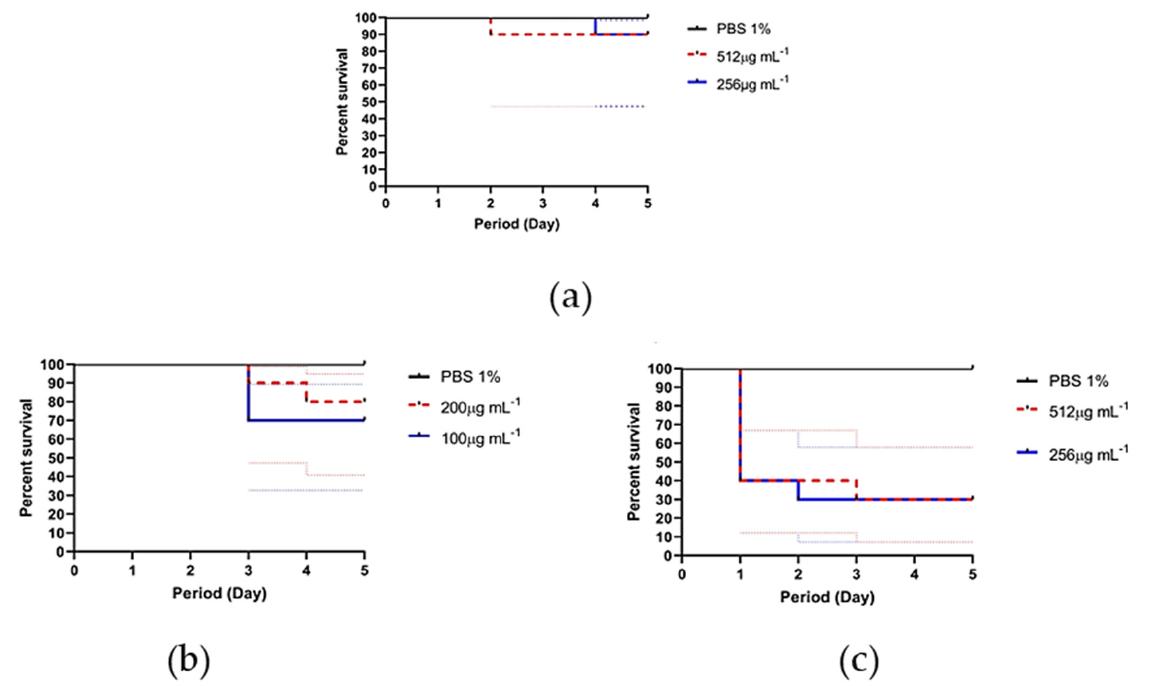
Figure 4. Survival curve of Tenebrio molitor larvae treated with crude extract or hexane fraction of Vernonanthura brasiliana (L.) H. Rob and leishmanicidal reference drug Glucantime ® . The larvae were treated and evaluated daily for a period of 5 days. ( a ) Larvae with hydroalcoholic crude extract (EB Vb ); ( b ) Larvae with Glucantime ® ; ( c ) Larvae with hexane fraction (FH Vb ). Solid lines represent survival over time and dotted lines represent the 95% confidence interval. Larvae treated with sterile 1% PBS were considered negative control.